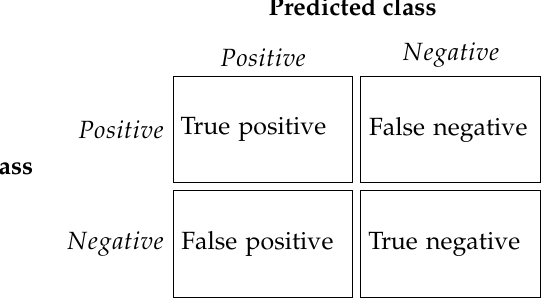
Figure 4. Confusion matrix: rows represent the actual classes while columns represent the prediction. The matrix has four possible values, corresponding to the four possible combinations of predicted and actual